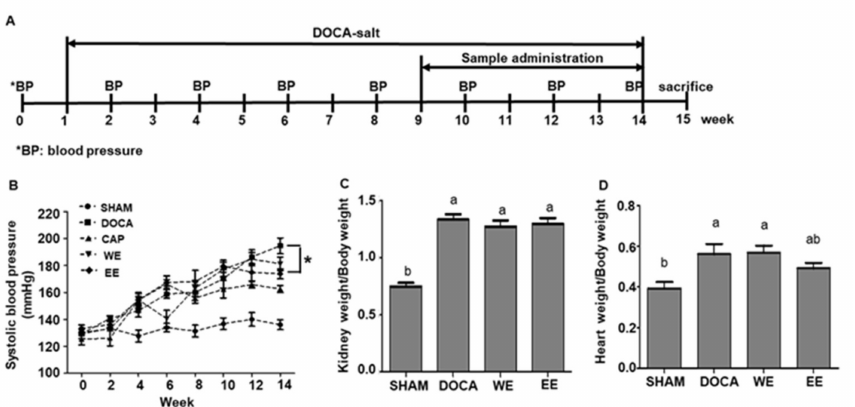
Figure 2. Effects of administration of water extract (WE) and ethanol extract (EE) of L. rhamnosus AC1-fermented soymilk on DOCA-salt hypertensive rat. Timeline of animal experiments ( A ). Results of systolic blood pressure ( B ), the ratio of organ weight to body weight in the case of the kidney ( C ) and heart ( D ). Data are presented as means ± SEM ( n = 5). Bar values bearing different letters were significantly different by Duncan’s multiple range test ( p < 0.05). *, differences between the selected values were statistically different by Duncan’s multiple range test ( p < 0.05).